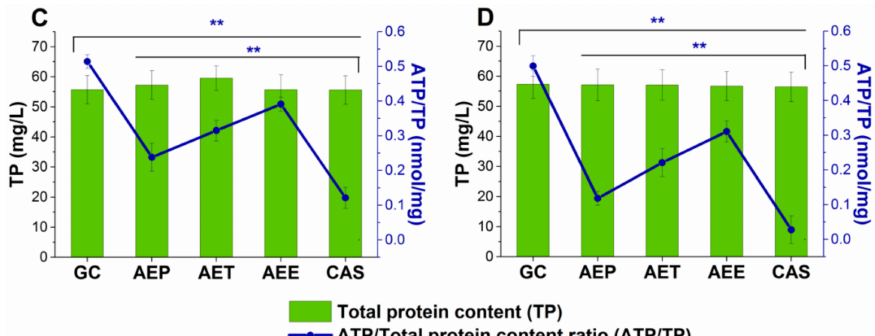
Figure 18. E ff ects of AEP, AET and AEE after 24 h of treatments at their respective MEC 10 concentrations on the ATP and the total protein content (TP) of C. albicans ( A ), C. tropicalis ( B ), C. dubliniensis ( C ) and C. krusei ( D ) cell populations in the mature biofilms (mean ± SD, n = 6 independent experiments each with three technical replicates, data were compared with untreated controls (GC) and with caspofungin (CAS)-treated positive controls. The blue double asterisks ( ** ) represent a significance value of P < 0.01 for the intracellular ATP / Total protein content (ATP / TP),